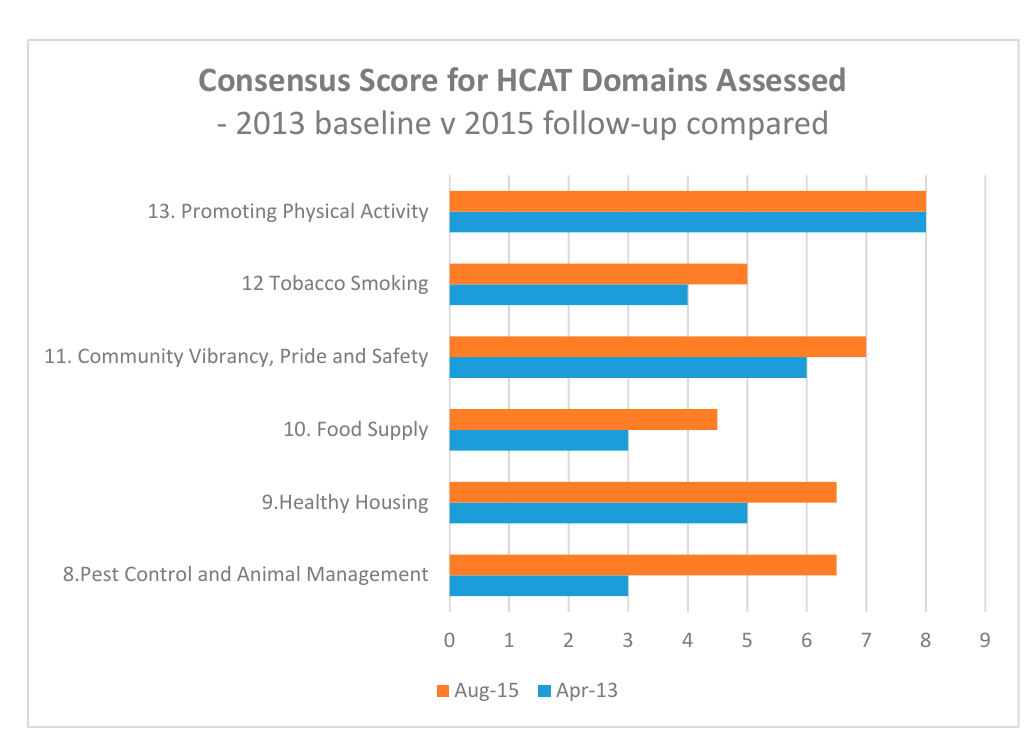
Figure 2. Consensus scores for HCAT domains assessed, baseline (April 2013) and follow-up (August 2015)